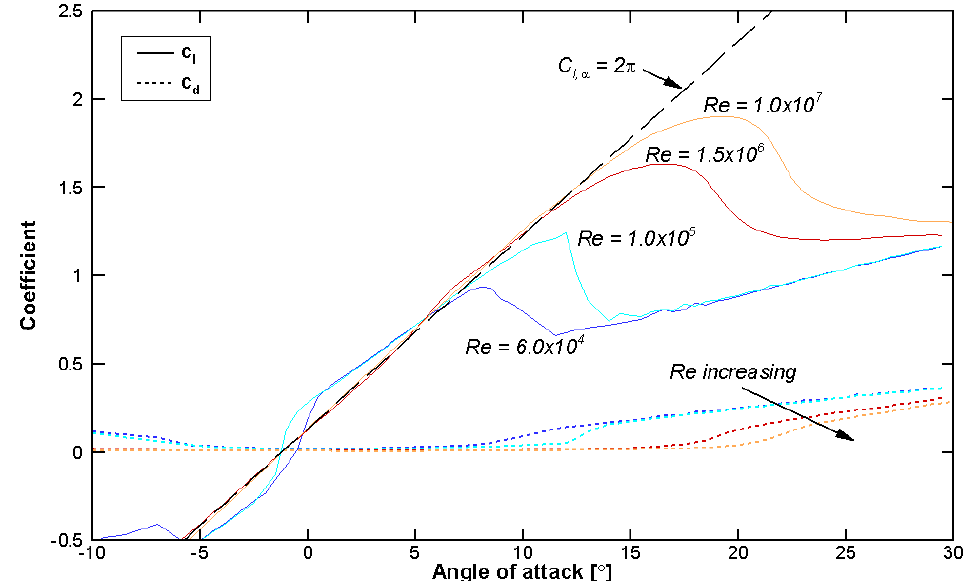
Figure 11. Lift and drag characteristics of the NACA23012 airfoil at variable Reynolds numbers.